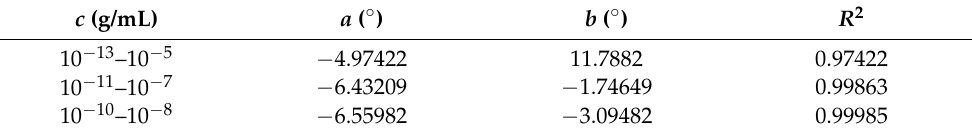
Table 2. Linear regression parameters for the plot of effective tilt angle θ (in degrees) versus BSA concentration c (in g/mL). Regression analysis was performed on the θ values within three different BSA concentration ranges for